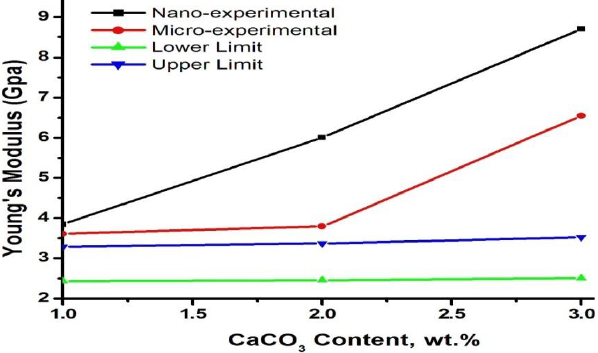
Fig. 13. Comparison of predicted Young’s modulus from Hash- in-Shtrikman equation to experimental data: micro- and nano-com- posites.